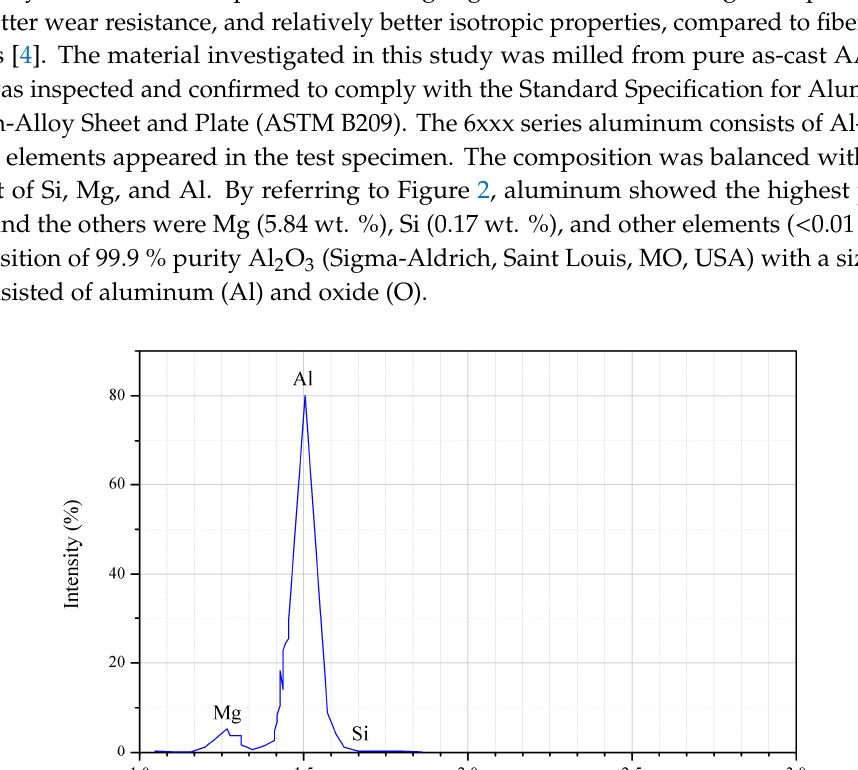
Table 1. Selected milling parameters.